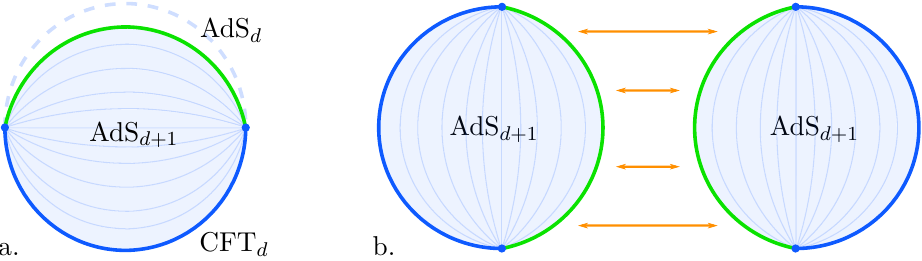
Figure 3. A timeslice of our Randall-Sundrum setup. In panel (a), we cut off the AdS d +1 spacetime along an AdS d slice near the asymptotic boundary θ = 0 , in the metric (2.3). Two of these spaces are glued together in panel (b) and the brane is realized as the interface between the two